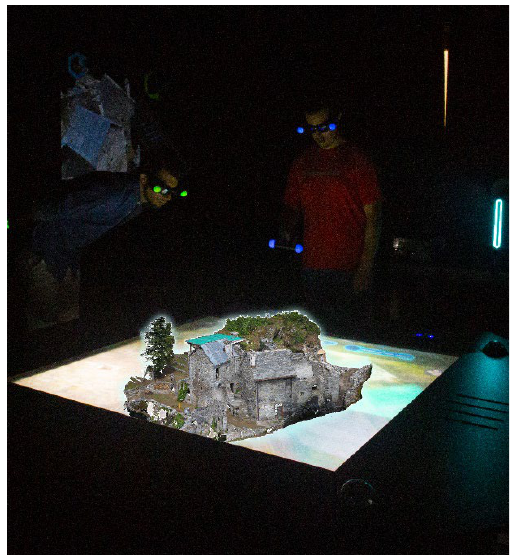
Figure 9 . The Ghesc village RGB holographic visualization.